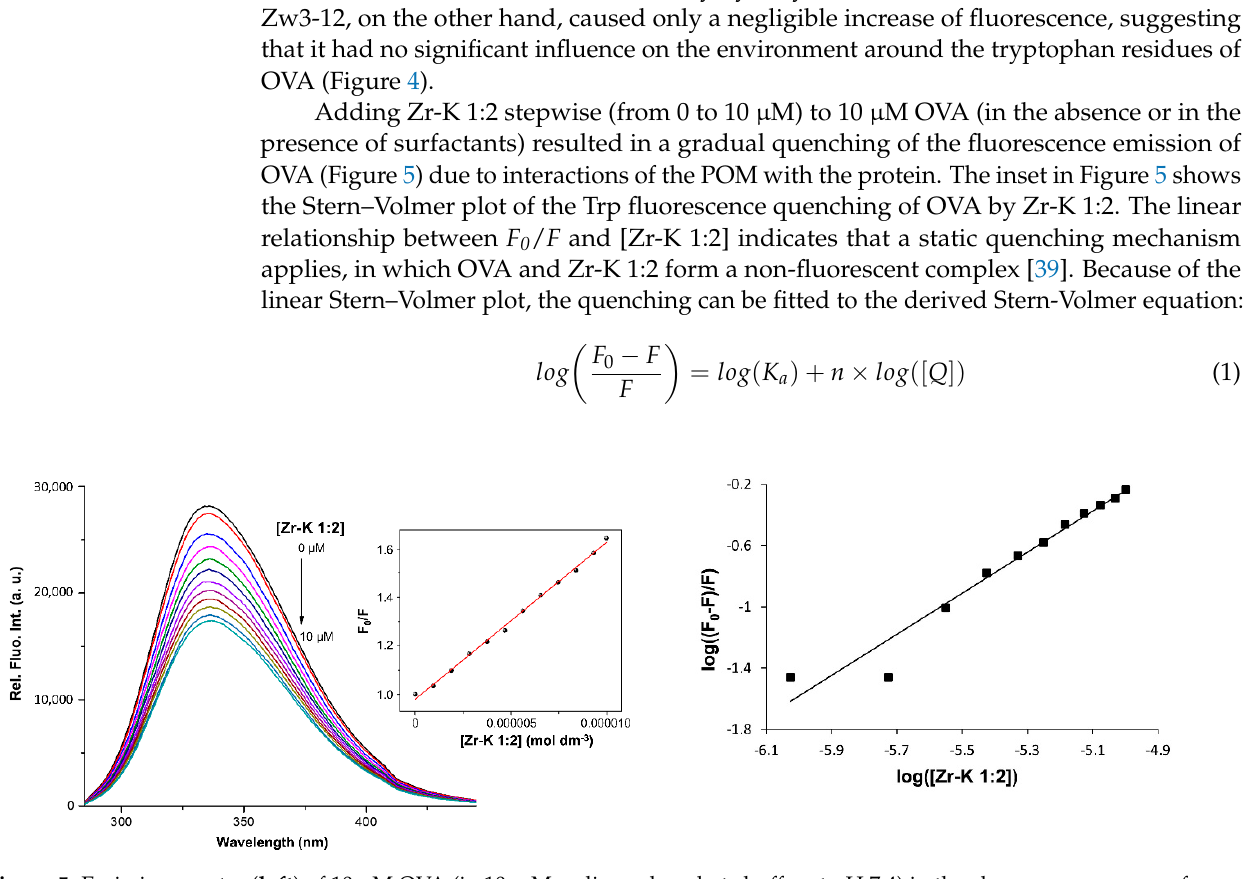
Figure 4 . The emission intensity of 10 µM OVA at pH 7.4 (10 mM sodium phosphate buffer) in the presence of increasing concentrations of Zw3-12, CHAPS, or SDS. The λ max is situated around 337 nm, and remained unaffected by the presence of surfactants.